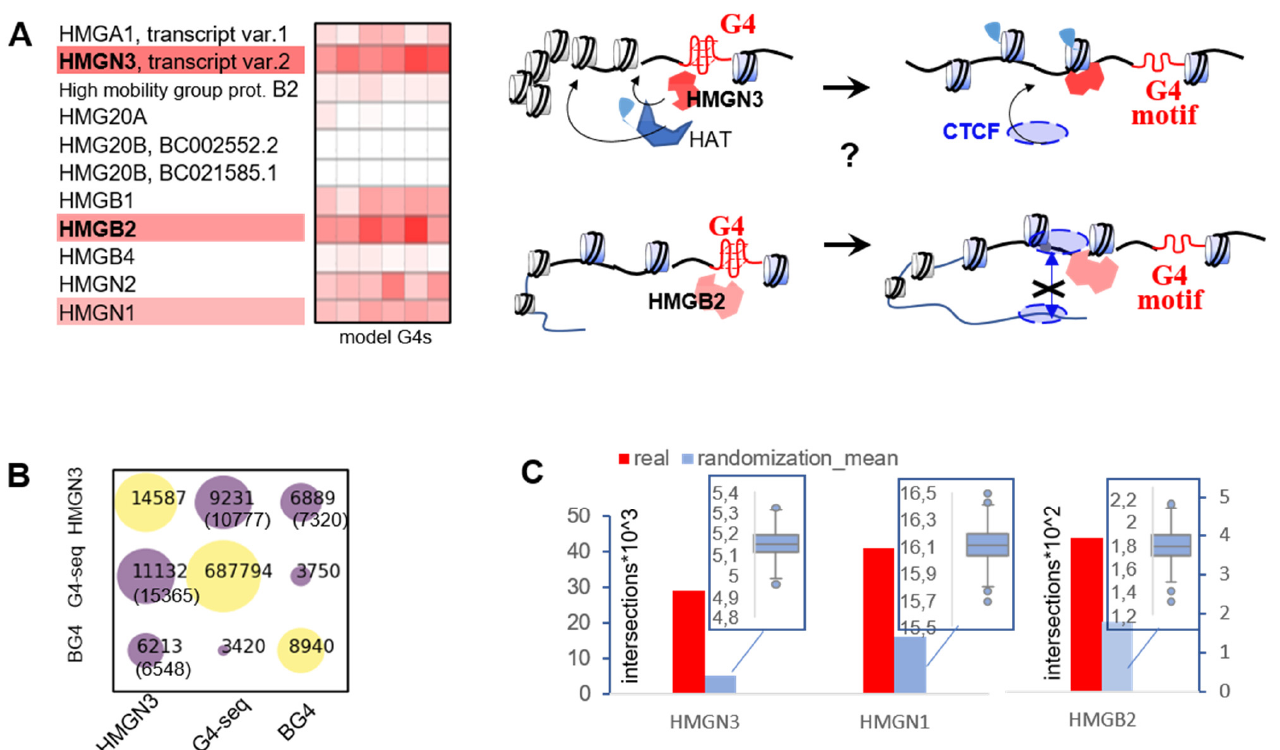
Figure 6. Search for G4-binding chromatin modulators that may affects CTCF positioning. ( A ) A heatmap summarizing G4 binding affinity (while, low; red, high) of HMG proteins in previous assays and hypothetical schemes summarizing the link between G4s, HMG and CTCF: the presumed recruitment of HMGN1 and HMGN3 to G4-prone sites induces chromatin decondensation by the disruption of internucleosome contacts and activation of histone acetyltransferase (HAT). Recruitment of HMGB2 prevents CTCF aggregation. ( B ) Intersection table for HMGN3 ChIP-seq, G4-seq and G4 ChIP-seq (BG4) peaks in K562 cells. The values equal to the number of intersections. Data in parentheses represent the number of G4- seq/BG4 peaks intersecting HMGN3 peaks with flanks ( ± 200 bp). ( C ) Whole-genome analysis of the intersections between G4-seq peaks and HMG protein-bound sites and significance of the G4-HMG correlations (Monte-Carlo simulation results). Red boxes indicate the true number of G4-seq-overlapping HMG protein peaks. The boxplots refer to the randomized